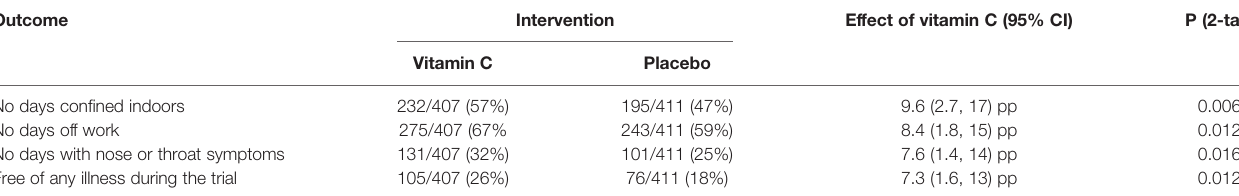
TABLE 1 | Effect of vitamin C on the proportion of participants with illness in the large Anderson (5) trial. Outcome Intervention